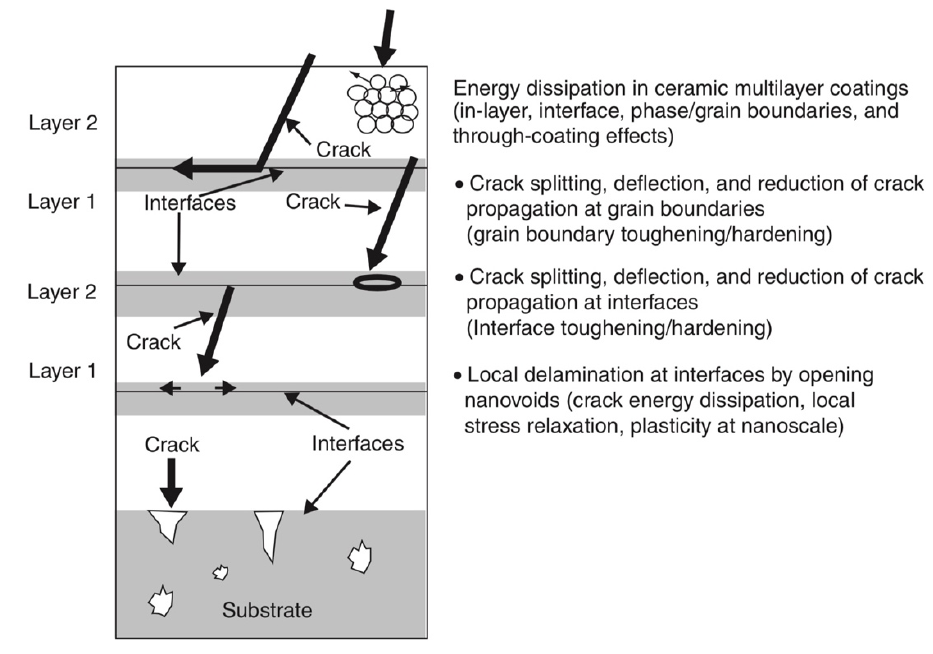
Figure 12. Toughening and strengthening mechanisms in multilayer coatings (taken from [159]).